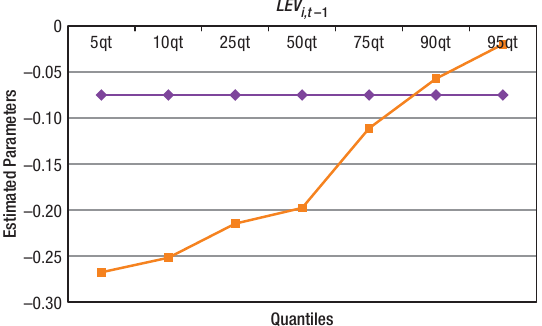
Fig. 3. Estimated parameters of relationship between I Notes: 1. The linear relationship represents OLS regression. 2. The non-linear relationship represents quantile